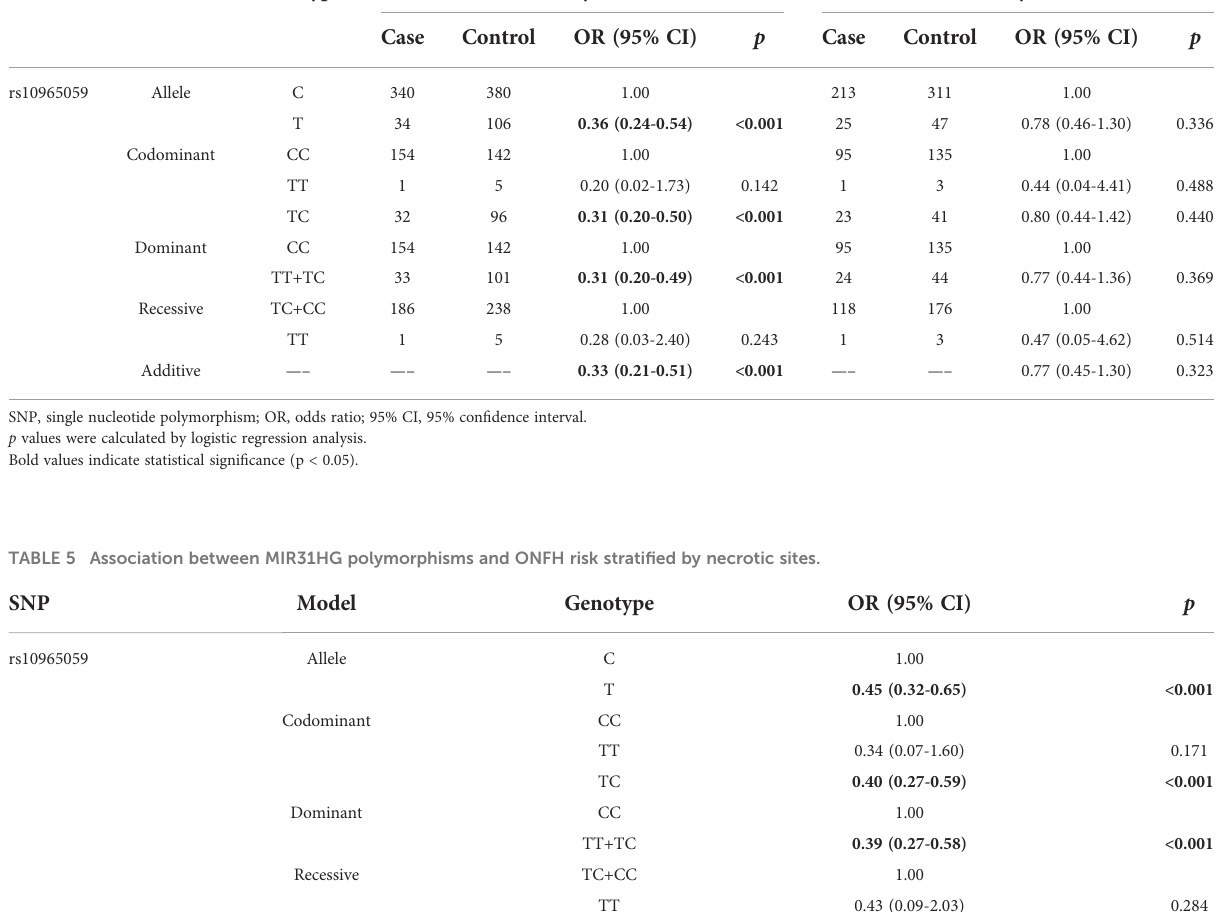
TABLE 4 Relationships between MIR31HG SNPs and alcohol-induced ONFH susceptibility based on strati fi cation by age. SNP Model